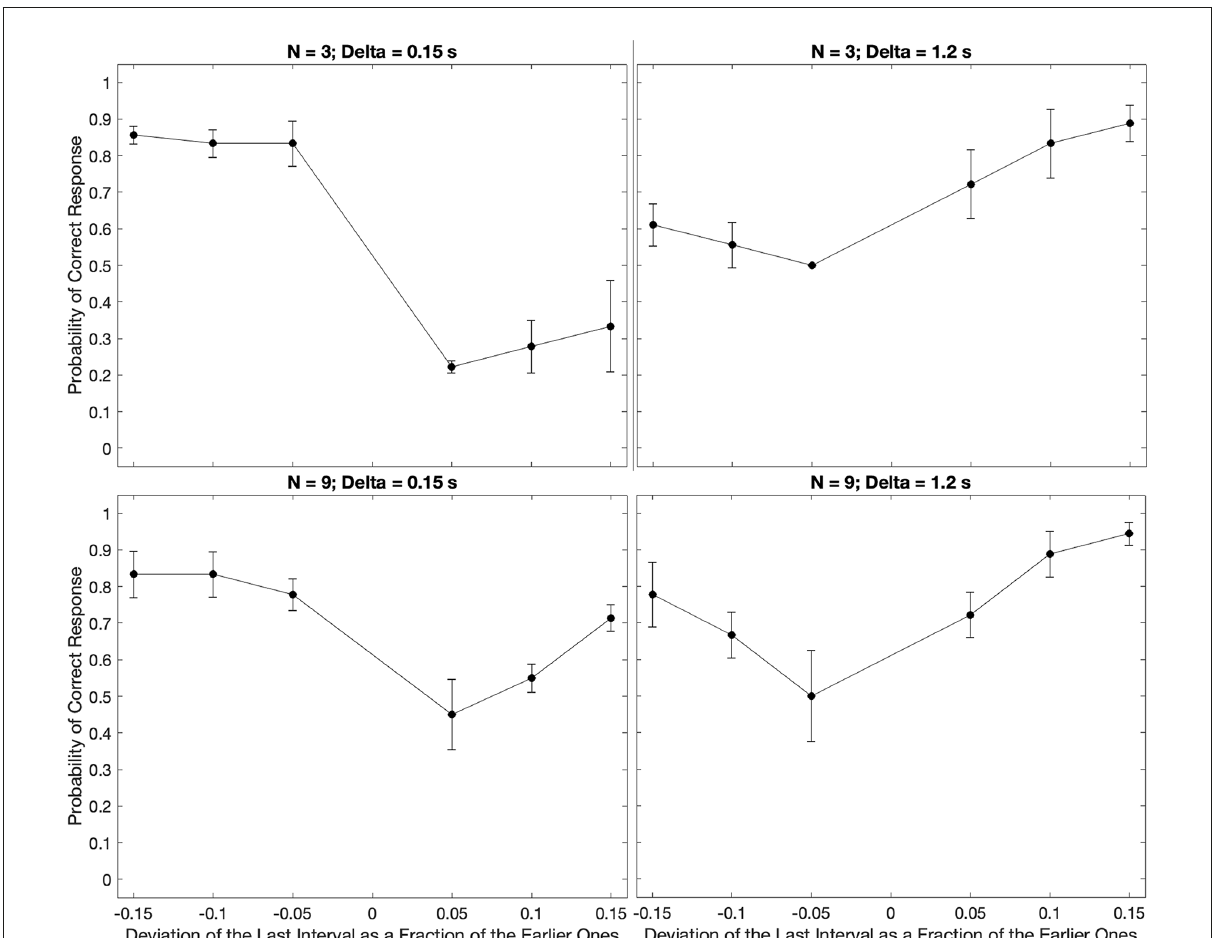
FIGURE3 Examples of the median of the data across subjects parametric on the number of beats and the inter-beat interval. Plot conventions are the same as in Figure 2 . These plots extend the conclusions from the subject in Figure 2 to the population. We observe both the U-shape behavior as a function of the relative deviations of the last interval and the same systematic errors for low and high inter-beat